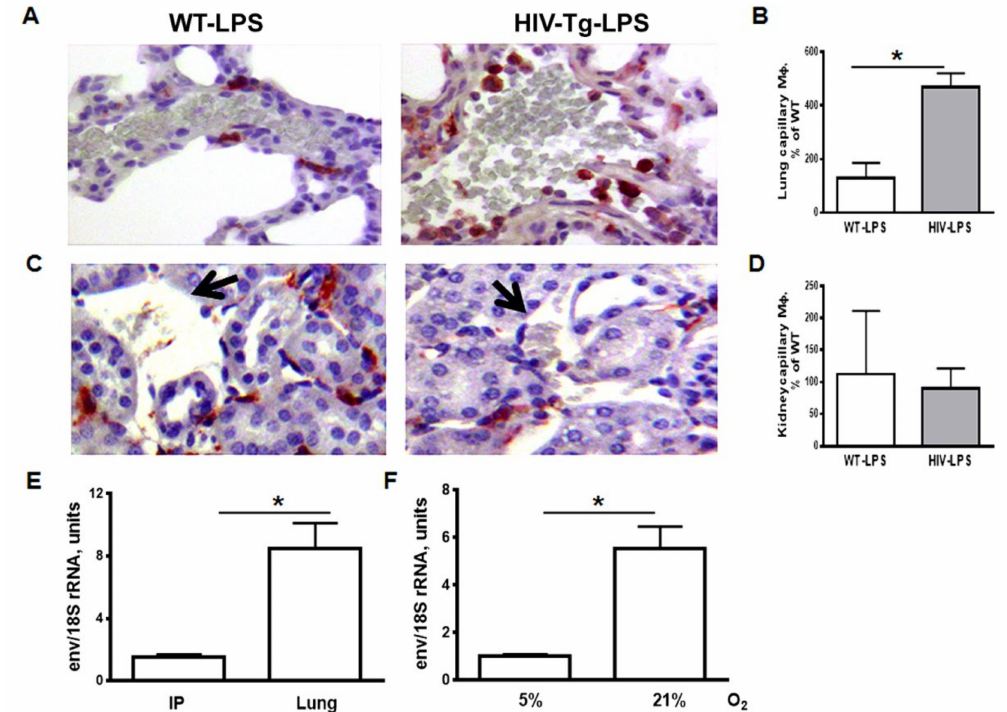
Figure 3. The level of capillary macrophage is increased in HIV-Tg mice at 24 h after LPS administration. ( A , C ) Macrophage immunostaining (red color) in the lung (panel A) and kidney (panel C) capillaries. Hematoxylin is used for counterstaining (purple nuclear staining). Original magnification is 400X. ( B , D ) Quantification of lung (panel B) and kidney (panel D) capillary macrophages. Results are shown as percentage of WT-LPS levels. n = 3. ( E , F ) qRT-PCR for HIV-1 env in peritoneal and lung M φ s (E, n = 4) and in peritoneal M φ s incubated for 72 h at 5% and 21% in vitro (F, n = 3). Mouse 18S rRNA was used for normalization. Mean and SD are shown. * p <